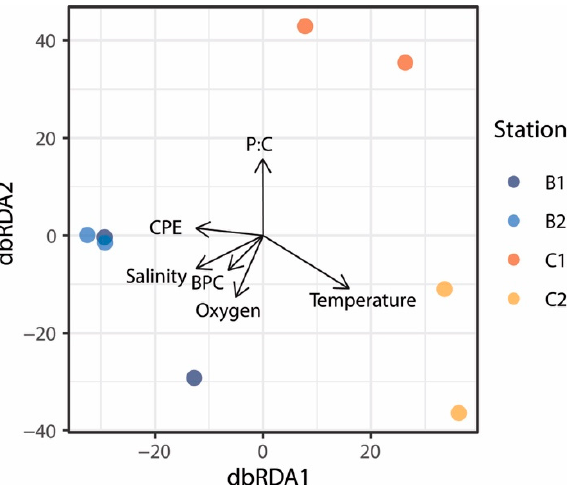
Figure 7. Output of the distance-based redundancy analysis (dbRDA) showing the relationships between the fungal assemblage composition and environmental and trophic variables analyzed in this study.